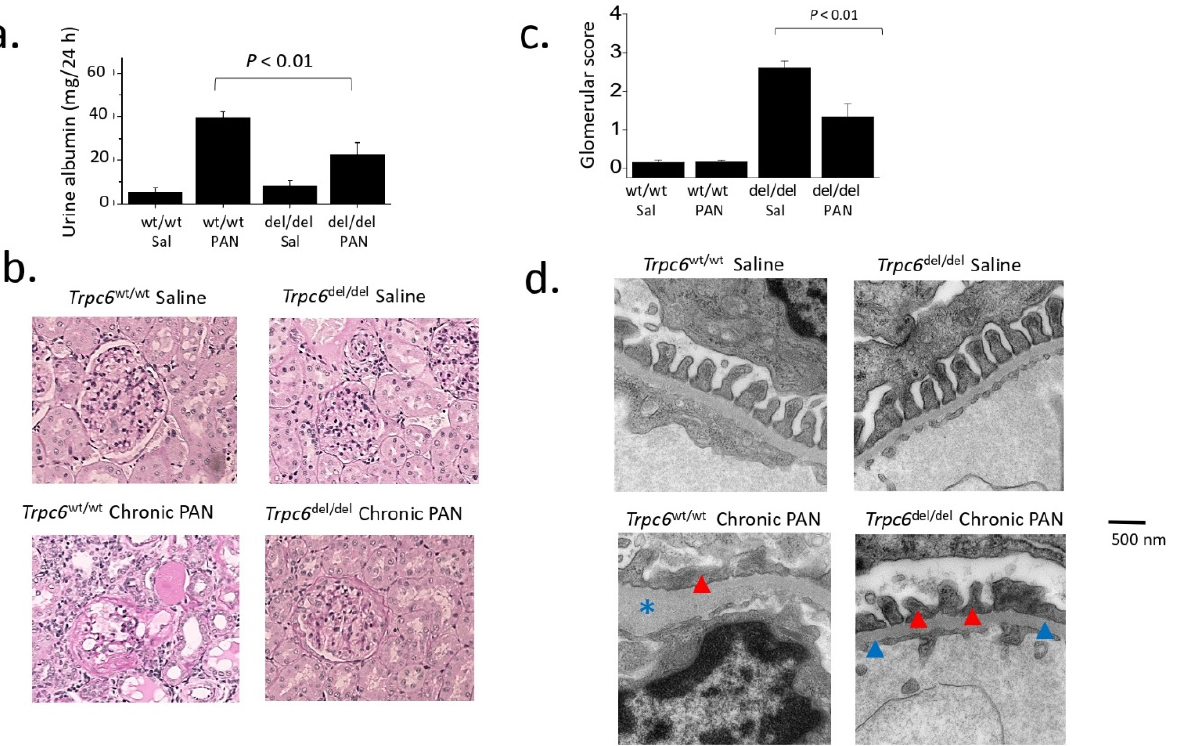
Figure 3. Effects of TRPC6 inactivation in the chronic PAN nephrosis model of adaptive FSGS. ( a ) Trpc6 del/del rats have reduced albuminuria during the chronic phase of PAN nephrosis compared to their Trpc6 wt/wt littermates. Urine was analyzed 60 days after the initial PAN injection. ( b ) Representative sections of renal cortex stained with periodic acid-Schiff’s show that glomerulosclerosis was less severe a Trpc6 del/del ras than in a Trpc6 wt/wt littermate. ( c ) Semiquantitative analysis of glomerulosclerosis based on experiments similar to that shown in ( b ), carried out on groups of animals. ( d ) Electron microscopy showing reduction in podocyte foot process effacement during chronic PAN nephrosis in a Trpc6 del/del rat compared to a Trpc6 wt/wt littermate. Foot processes are marked by red arrow heads. Note also markedly increased thickening of glomerular basement membrane (GBM) in micrograph from a Trpc6 del/del rat, marked by blue asterisk. Compare to normal glomerular basement membrane indicated by blue triangle. Additional details and analyses are in [50].